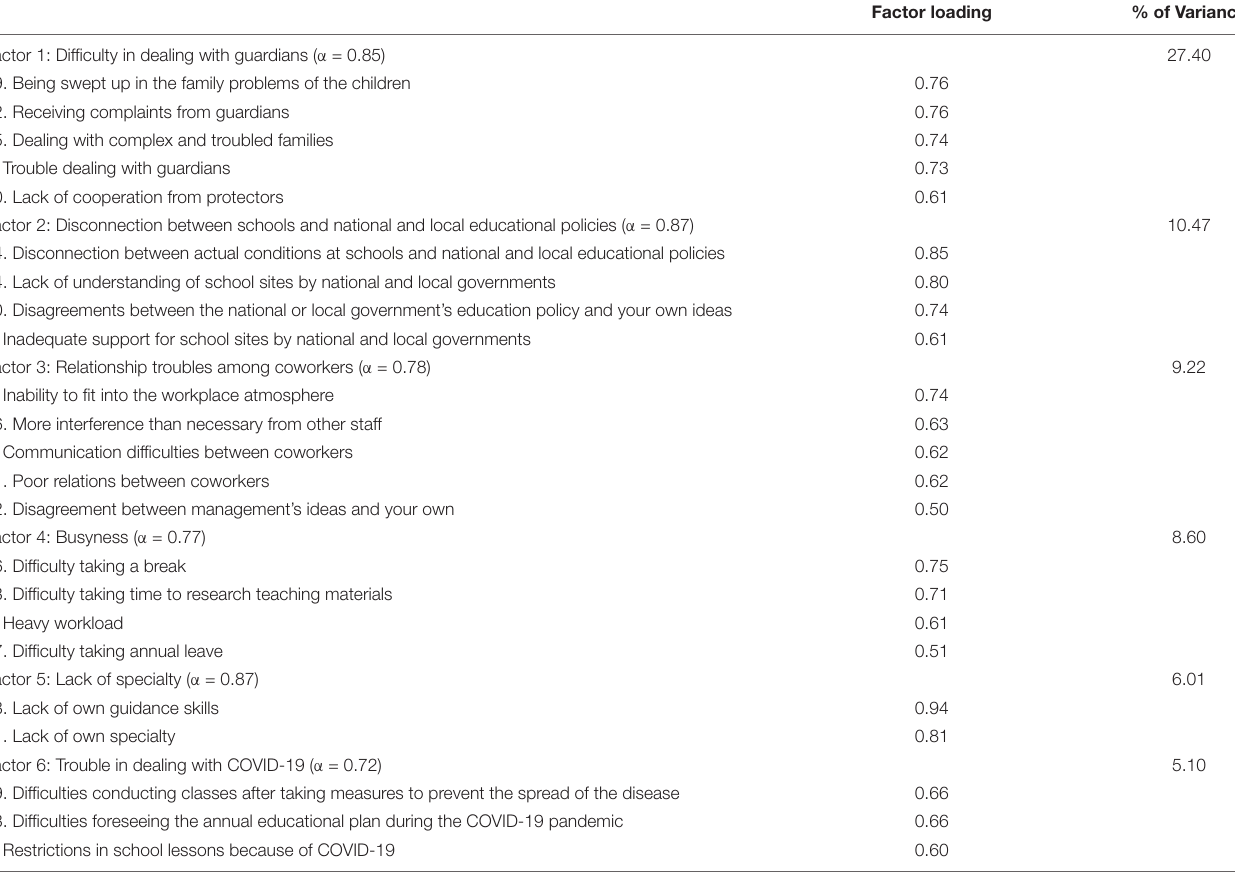
TABLE 1 | Factor analysis of the stressor scale for the special needs school teachers (unweighted least-squares method with promax rotation).